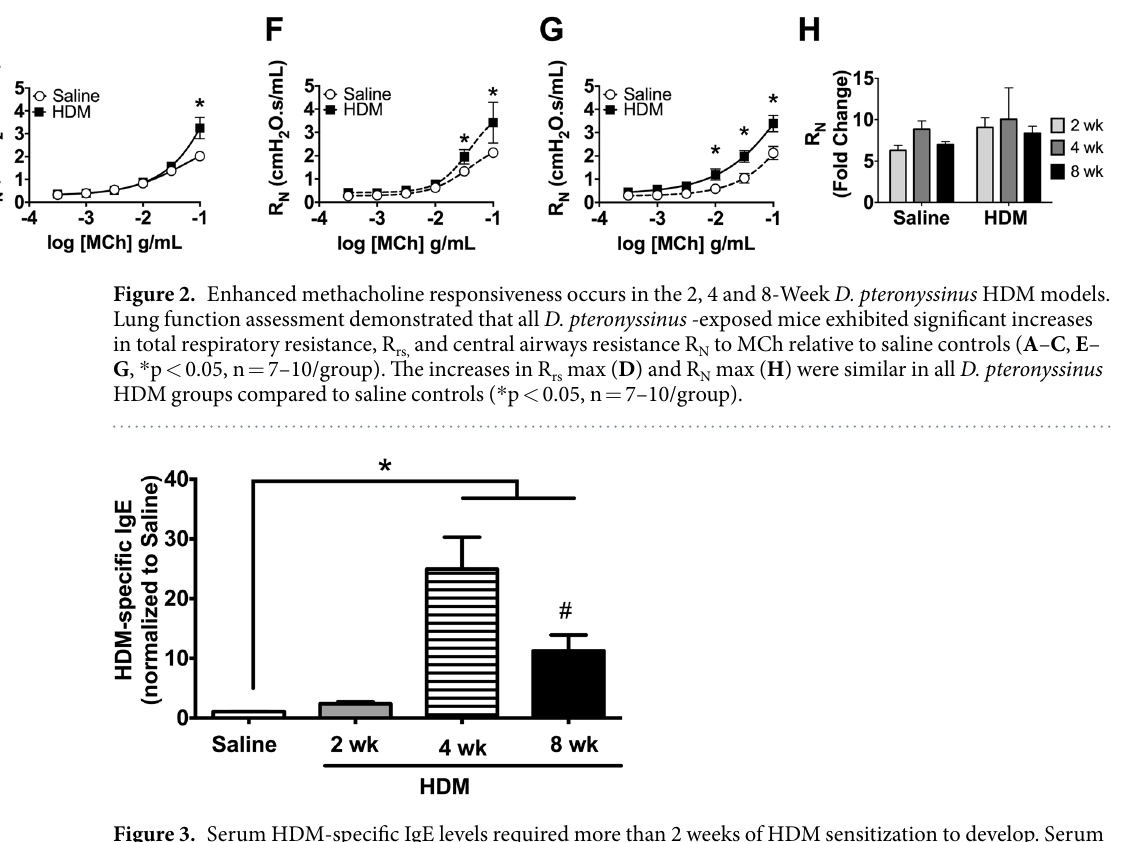
Figure 3. Serum HDM-specific IgE levels required more than 2 weeks of HDM sensitization to develop. Serum HDM-specific IgE was significantly increased in the 4-week (25 µ g) and 8-week HDM models, with the highest concentrations in the 4-week HDM mice ( * p < 0.05 vs Saline control; # p < 0.05, 4-week HDM vs 8-week HDM; n =